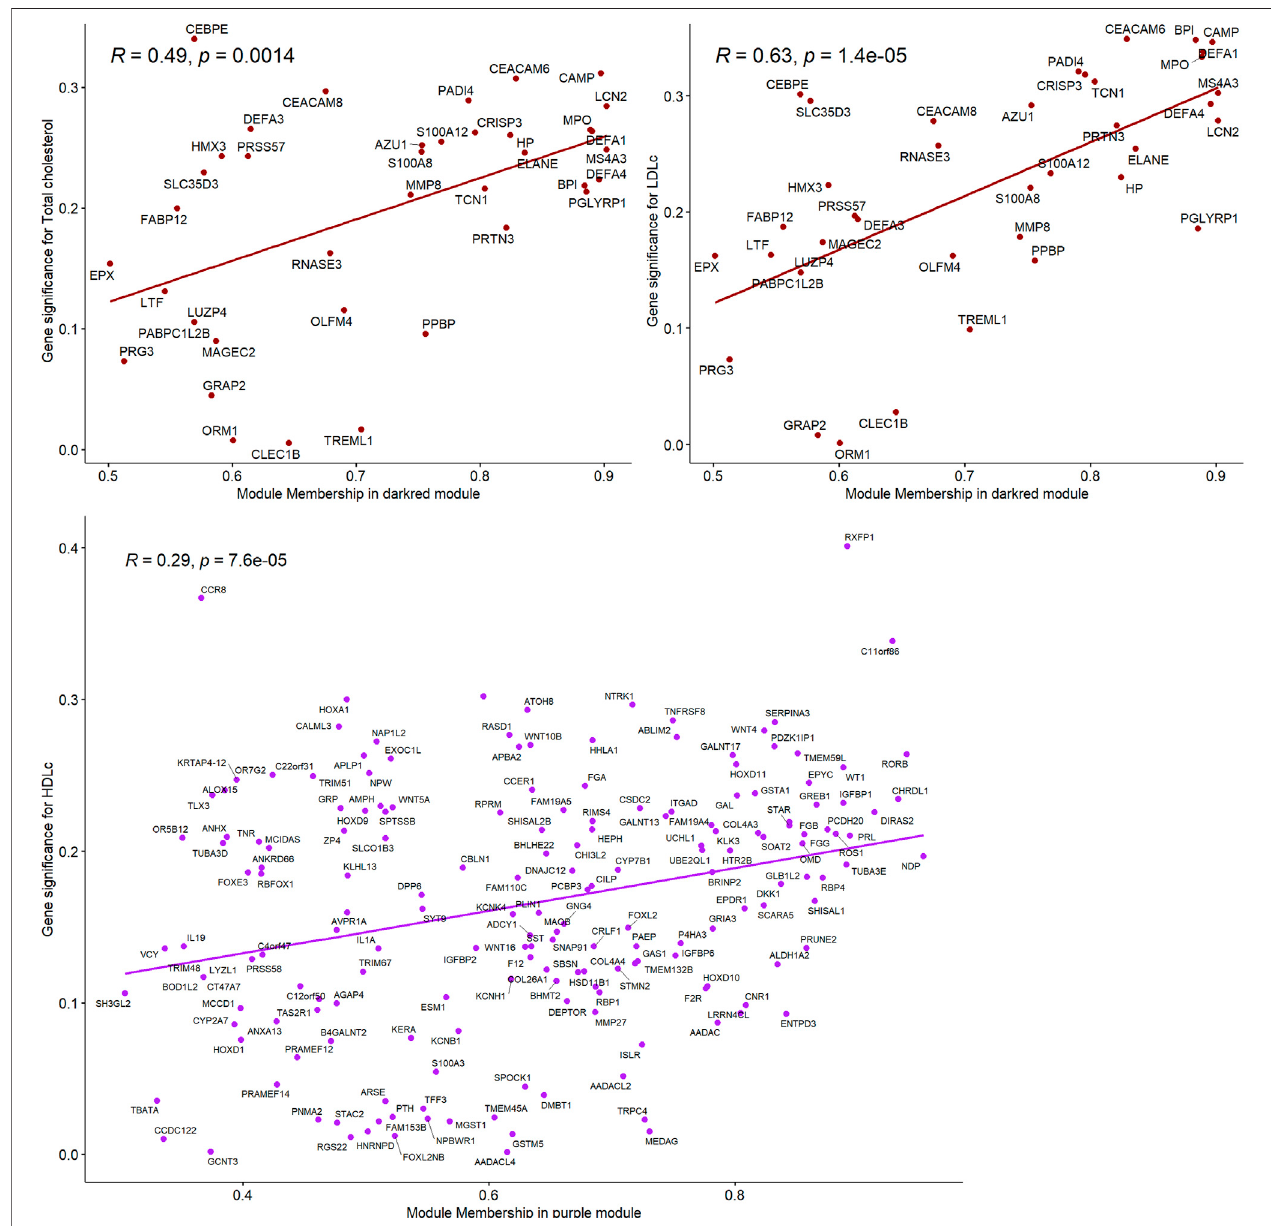
FIGURE2| Correlationsbetweengenemodule memberships and genesigni fi cance forthemodule “ darkred ” and Total cholesterol and LDL-C and forthemodule “ purple ” and HDL-C.